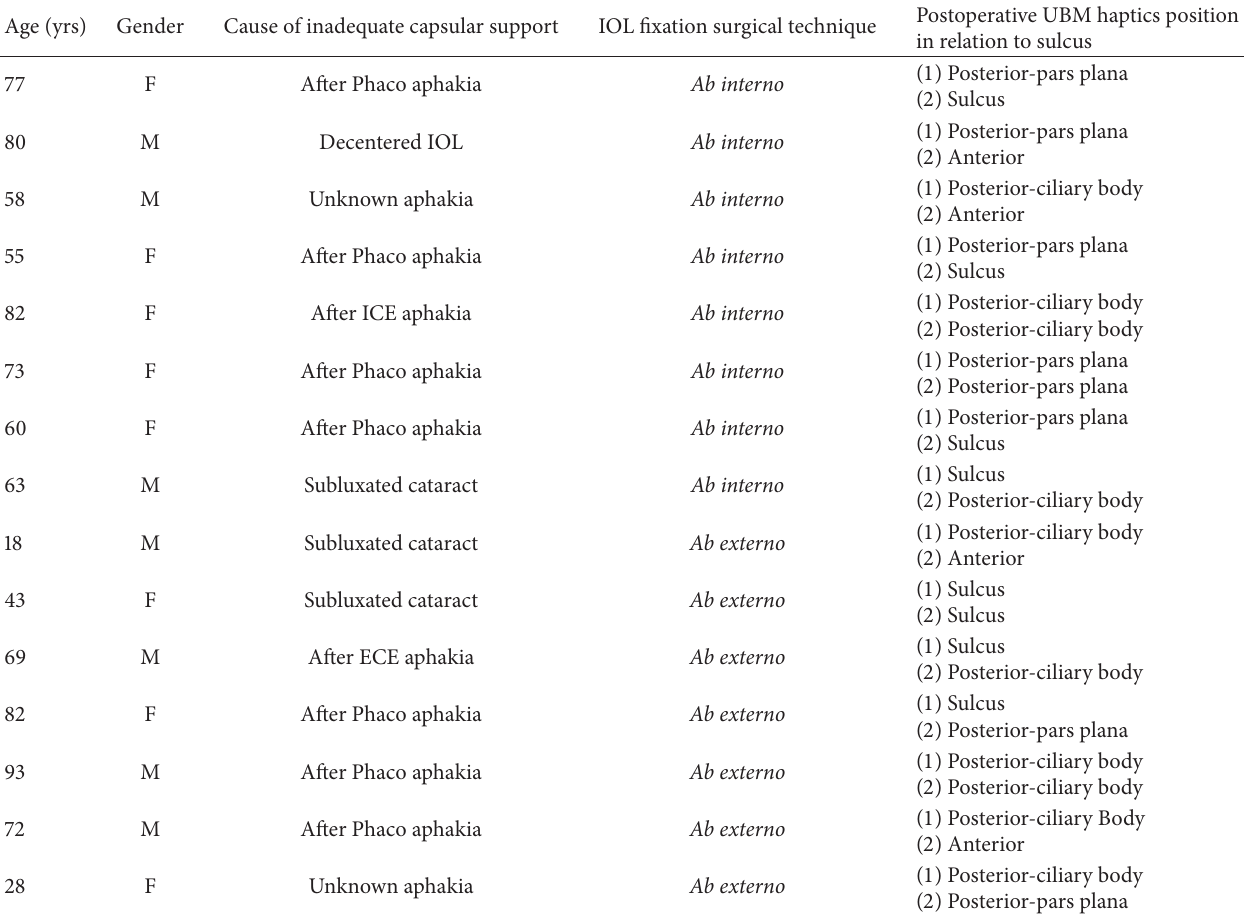
Table 1: Demographics of the sample and cause and technique used for intraocular lens fixation and postoperative IOL positioning evaluated using ultrasound biomicroscopy.